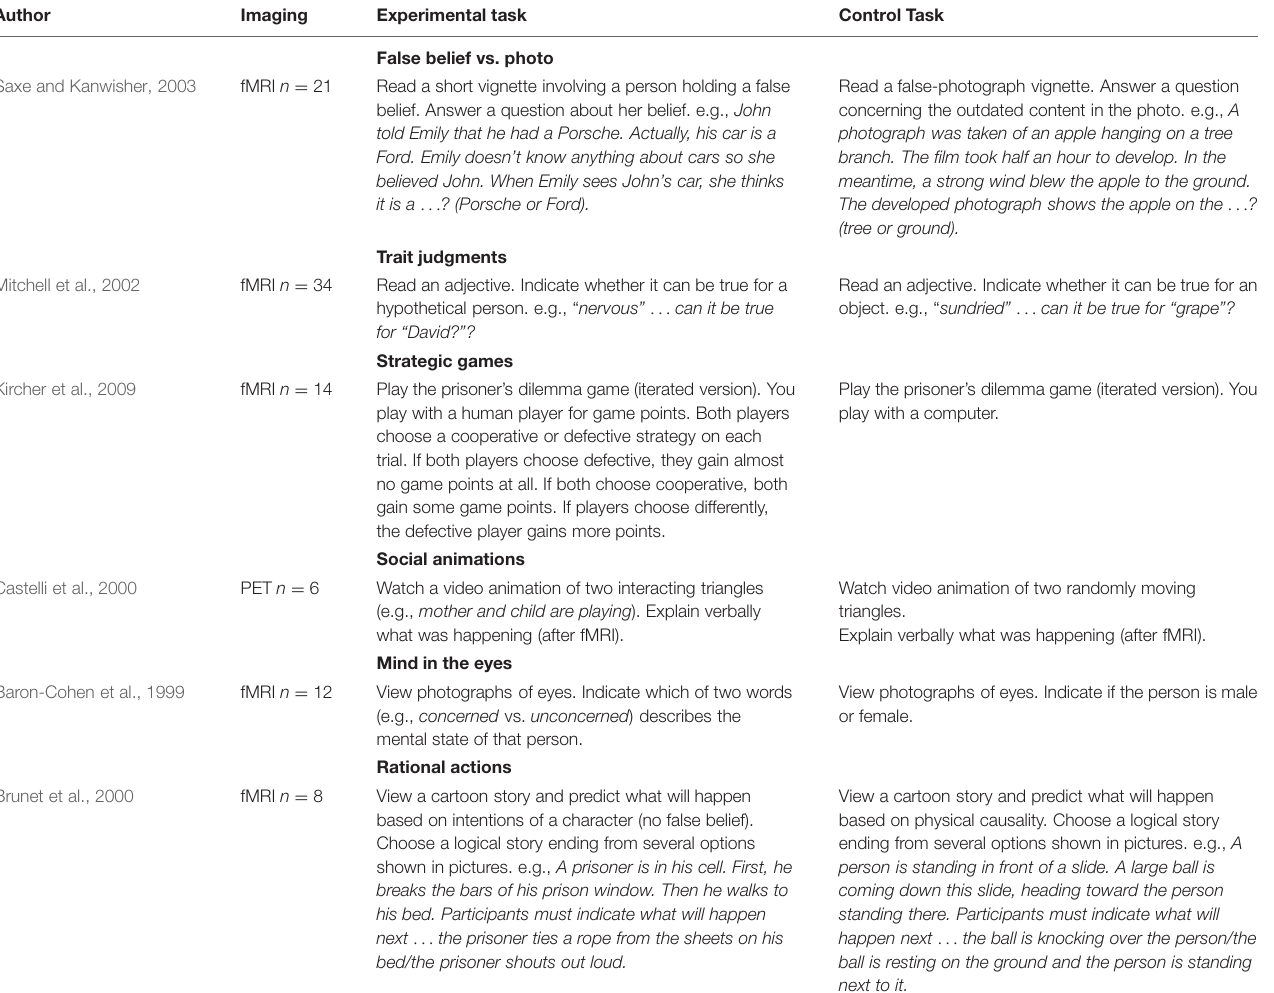
TABLE 1 | Examples from each task-group in the meta-analysis by Schurz et al.